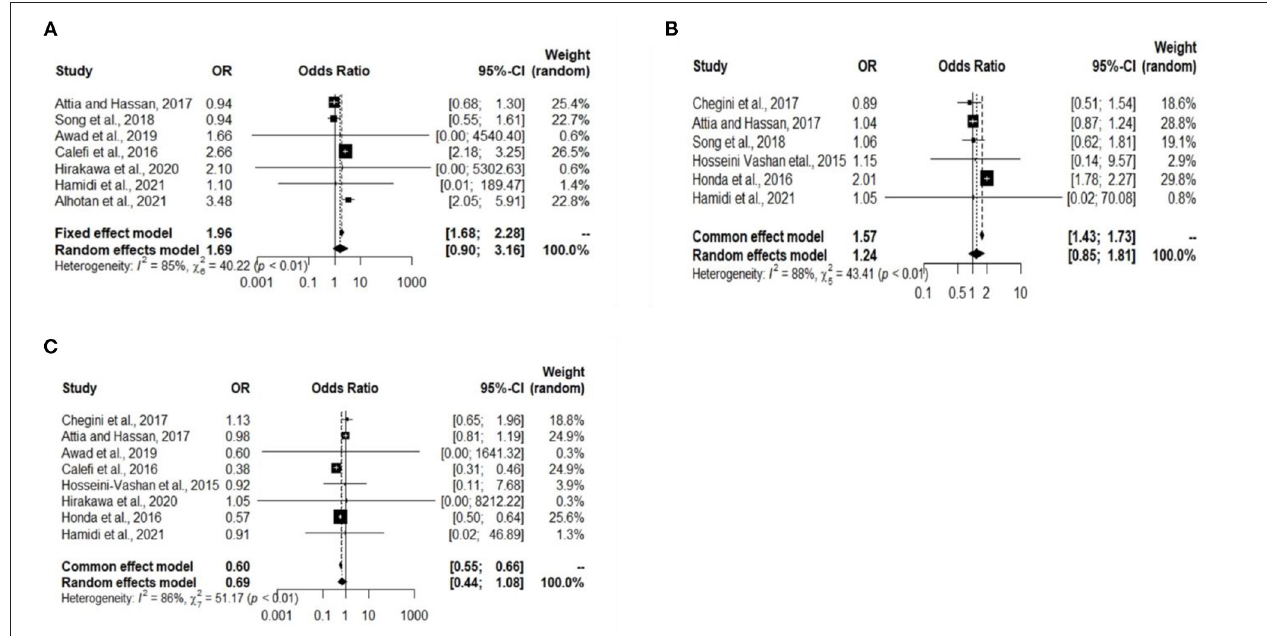
FIGURE 4 | Forest plots representing the effect of heat stress on immunoglobulins level. (A) Forest plot indicates that the heat stress significantly changes the broiler blood IgA, (B) forest plot indicates that the heat stress significantly changes the broiler blood IgG, and (C) forest plot indicates that the heat stress significantly changes the broiler blood